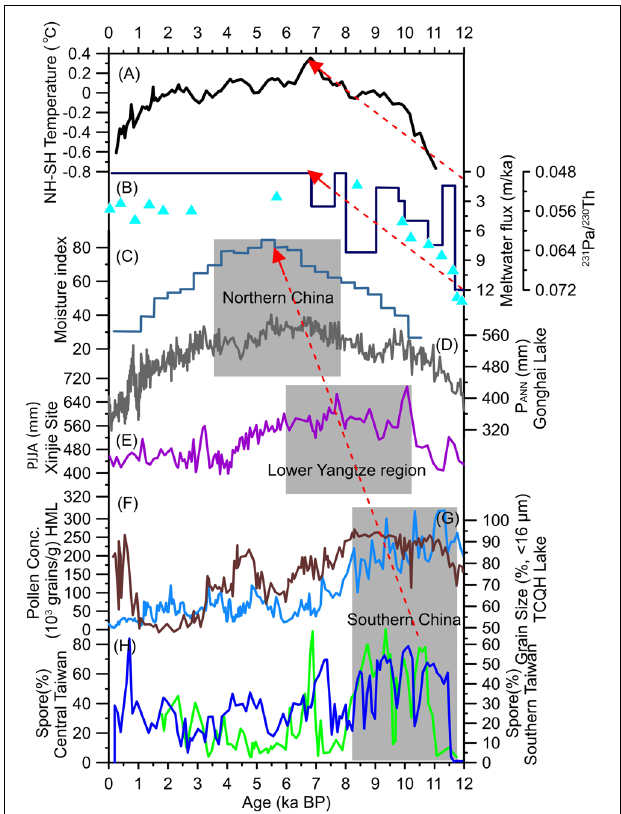
FIGURE 4 | Comparisons of the summer monsoon rainfall maximum across China. (A) North–South hemisphere temperature gradients (McGee et al., 2014). (B) Meltwater flux in the Northern Hemisphere in TRACE21 (dark blue line, Liu et al., 2014a) and 231 Pa/ 230 Th ratio in Western subtropical Atlantic (cyan triangles), a proxy for the AMOC (McManus et al., 2004). (C) Synthesized moisture index for arid/semiarid northern China (Li et al., 2014). (D) Annual rainfall from Gonghai Lake, northern China (Chen F. et al., 2015). (E) Summer rainfall reconstructions for the Xinjie site in the lower Yangtze region (Lu et al., 2019). (F) Variations in pollen concentrations from Huguangyan Maar Lake (The blue line, Wang et al., 2016). (G) Small grain size contents from Tengchongqinghai Lake (The brown line, Zhang et al., 2017). (H) Records of spore percentages from Toushe Basin (The green line, Liew et al., 2006) and from Dongyuan Lake (The dark blue line, Lee and Liew, 2010). The gray bars highlight the EASM rainfall